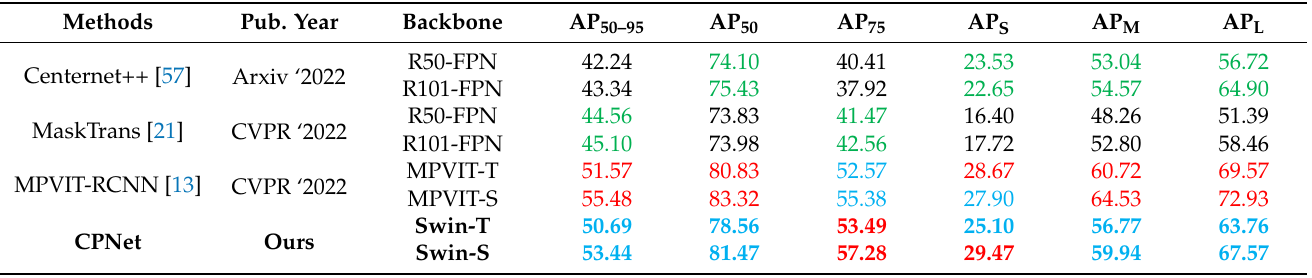
Figure 13. Visualization of detection results on the foggy driving dataset. Table 7. Experimental results on foggy driving dataset (the top three performances are highlighted in red, blue, and green, bold denotes our algorithm.).